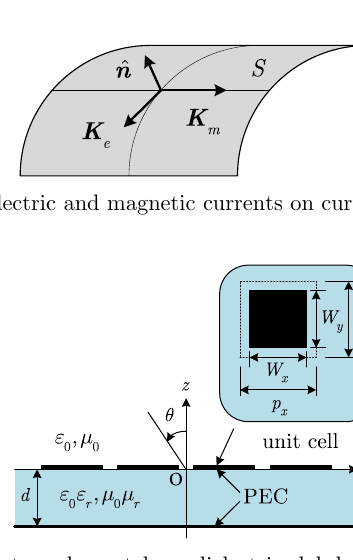
Fig. 2. Rectangular patch on dielectric slab backed